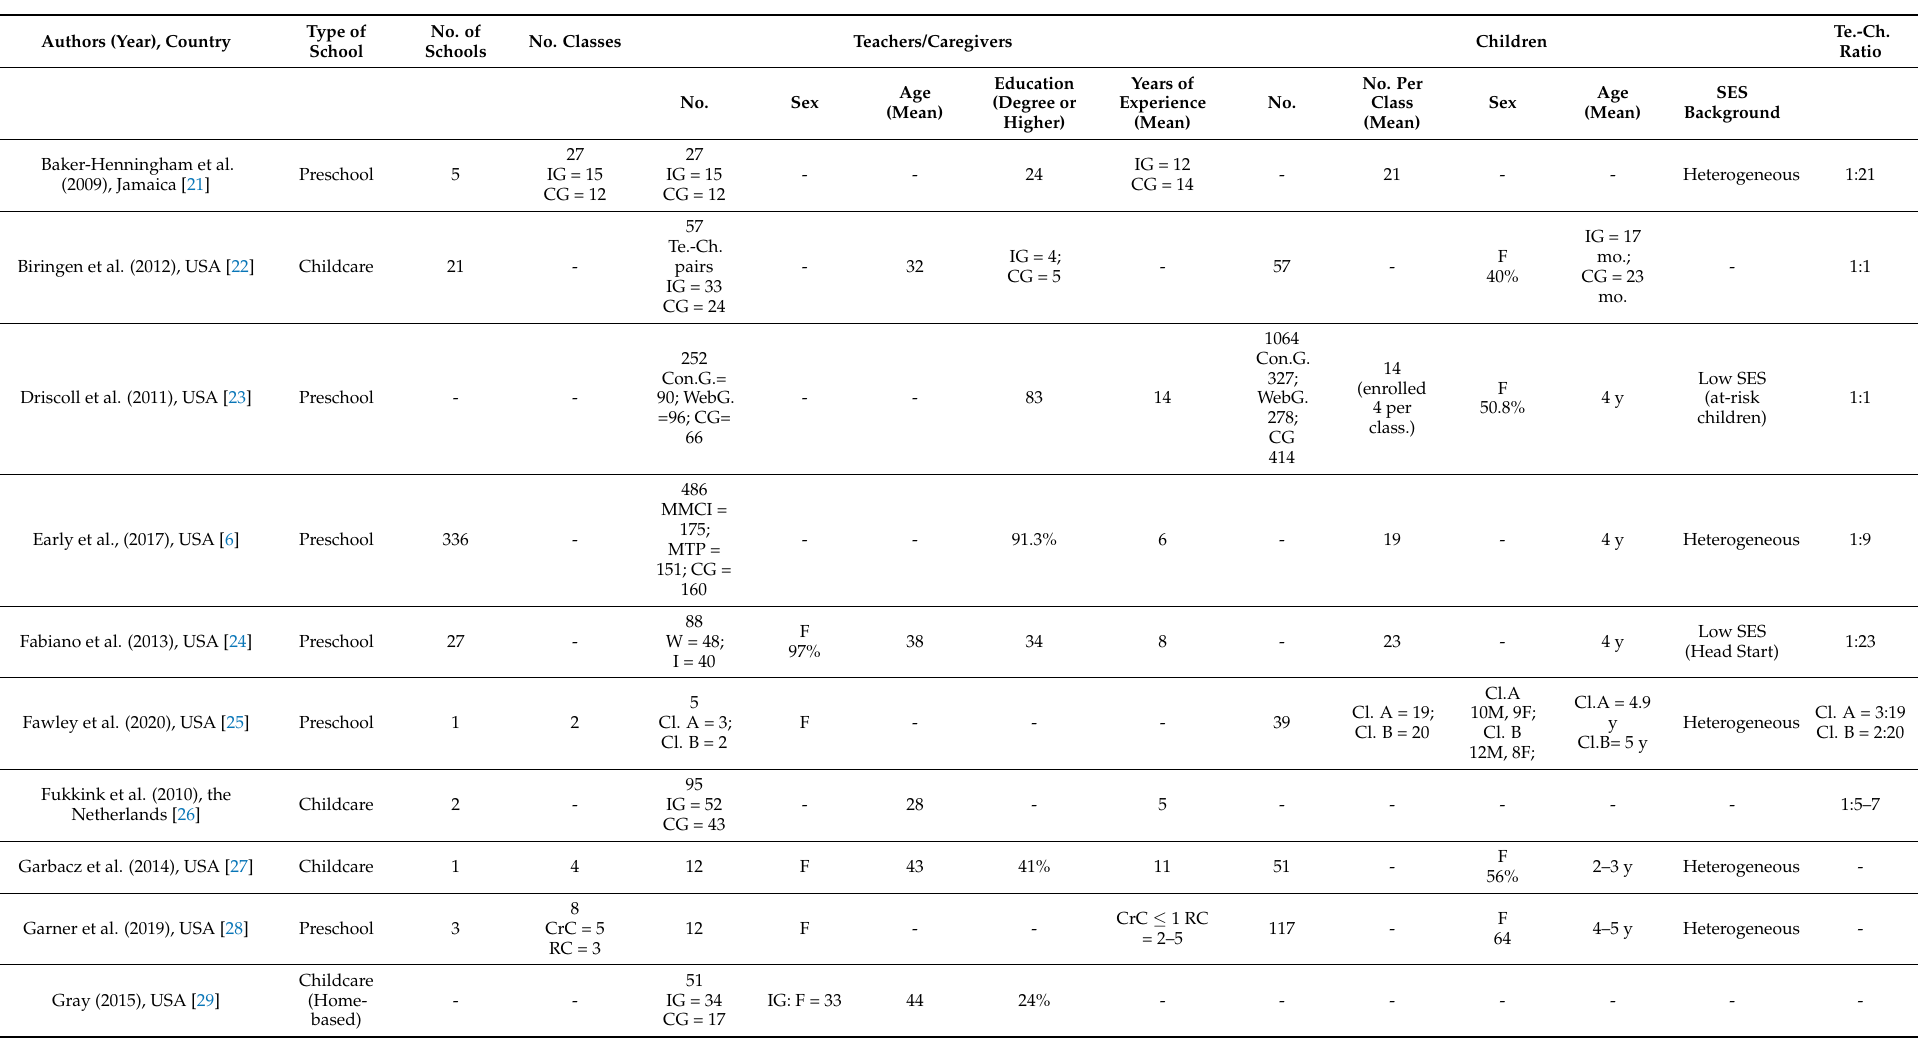
Table 1. Participants